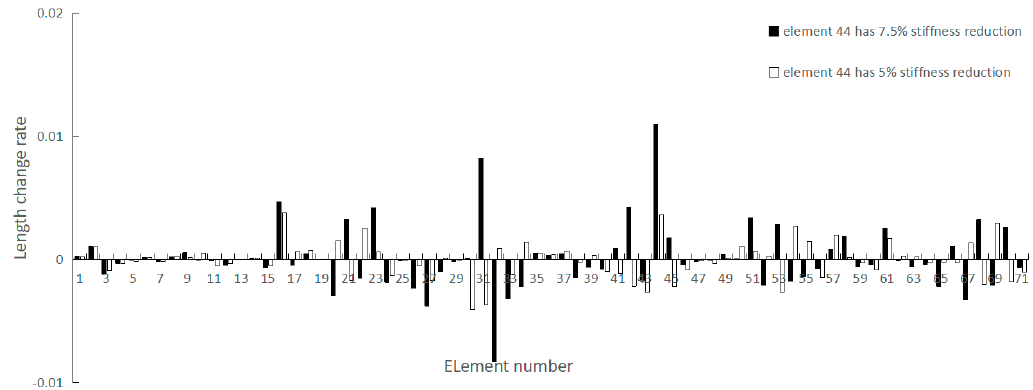
Figure 13. Length change rate of element obtained from the static data with an added 5% noise (element 44 has 7.5% and 5% stiffness reductions).